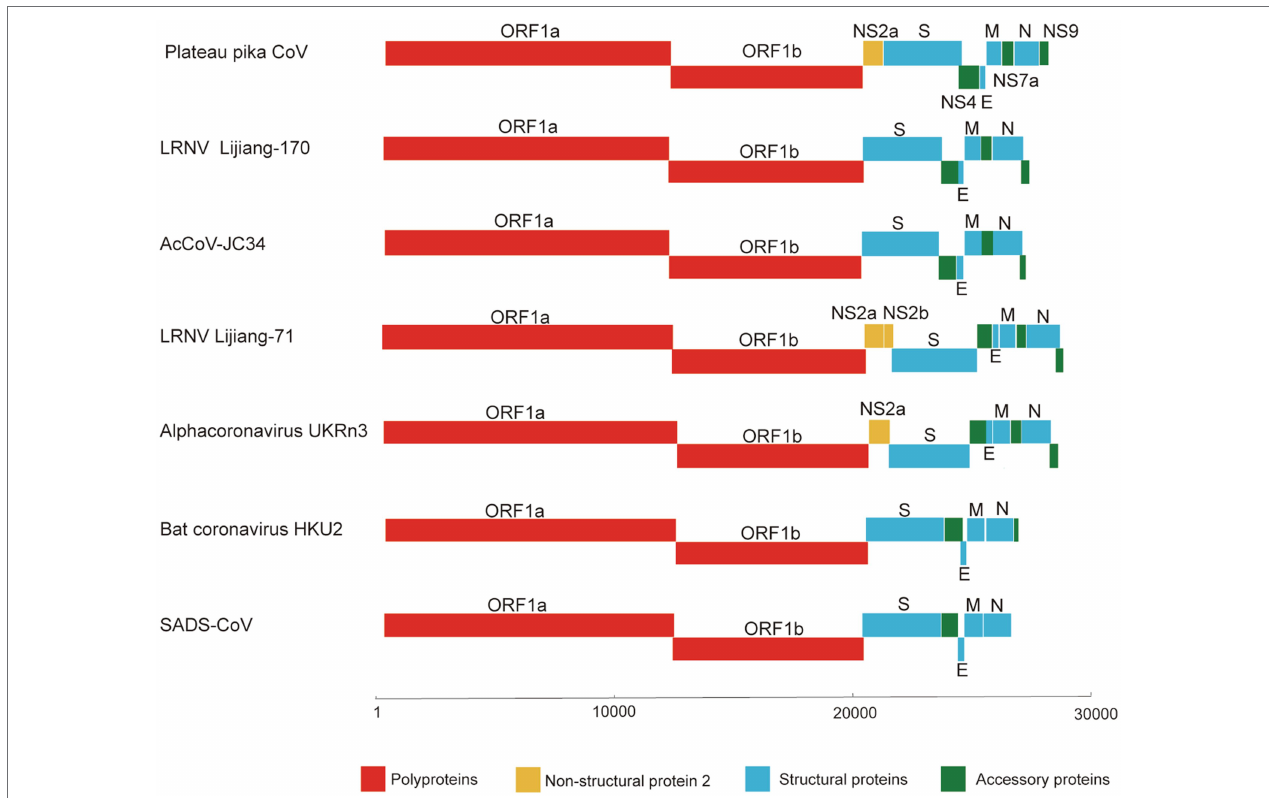
FIGURE 1 | Schematic diagram of the genomes of PPCoV and related representative alphacoronaviruses. LRNV, Lucheng Rn rat coronavirus; AcCoV-JC34, Coronavirus AcCoV-JC34; SADS-CoV, Swine acute diarrhea syndrome coronavirus.